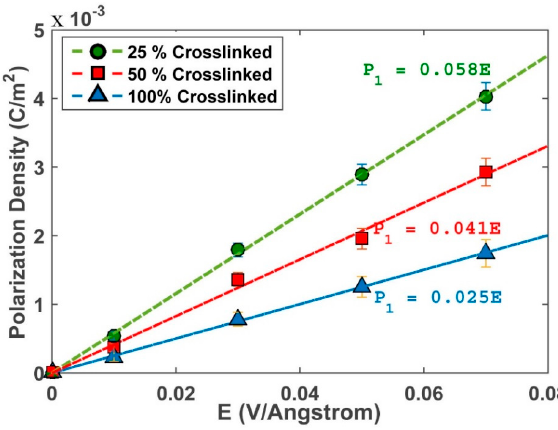
Figure 7. Graph of normalized polarization density versus electric field for different crosslinked systems.